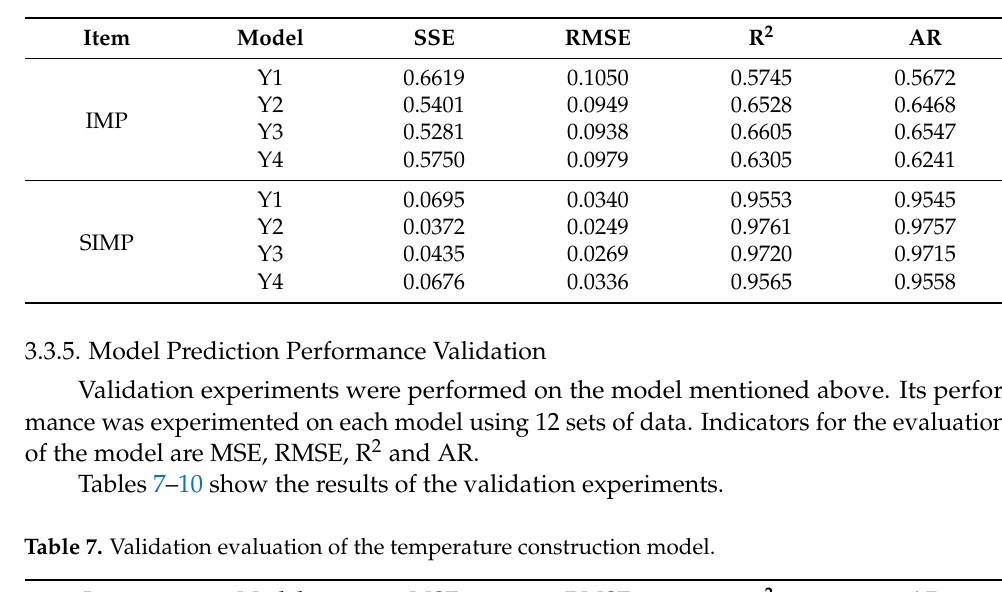
Figure 11. SIMP and NDVI model results. Table 6. Evaluation of the integration of multiple parameters model.